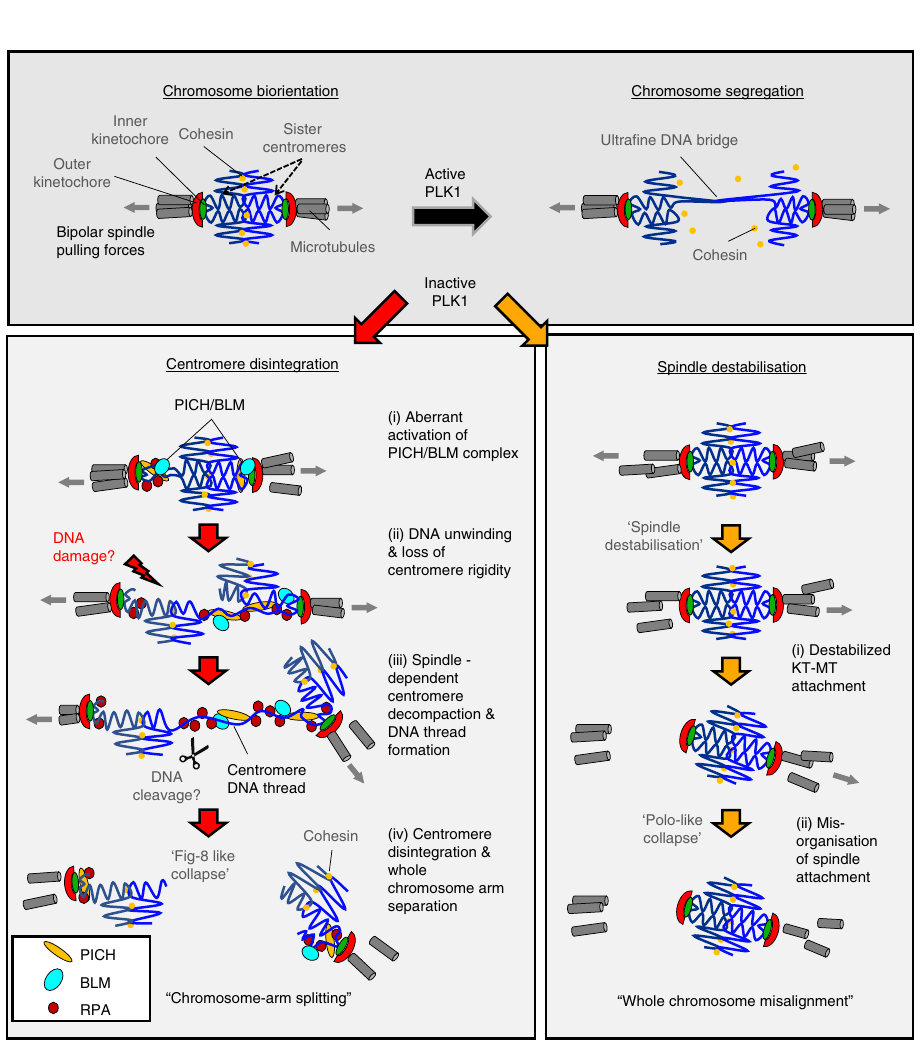
Fig. 9 A model of centromere disintegration in chromosome misalignment. Active PLK1 is required to stabilise chromosome biorientation for chromosome segregation. In addition to the existing role for spindle stabilisation, our current study demonstrates that PLK1 also functions to maintain centromere integrity for chromosome alignment. In the absence of PLK1 activity, centromeres are aberrantly targeted by BLM helicase in a PICH-dependent manner. It leads to unlawful, excessive formation of ssDNA, which impairs centromere con fi guration and weakens it ability to withhold kinetochore complexes. Forces exerted by the bipolar spindle attachment pull out the centromere chromatin, which might trigger further DNA unwinding by the PICH/BLM complex. As a consequence, it decompacts the centromere axis, leading to the formation of centromere DNA threads and whole-chromosome arm separation. Cells therefore fail to maintain chromosome biorientation and result in metaphase collapse with a ‘ Fig-8 ’ like misalignment pattern. Alternatively, if the spindle attachment is destabilised fi rst, it prevents centromere dislocation but this will lead to whole-chromosome misalignment, which probably manifests as more like a ‘ Polo ’ pattern. Therefore, we propose that PLK1 plays a multifactorial role in establishing and maintaining chromosome biorientation by